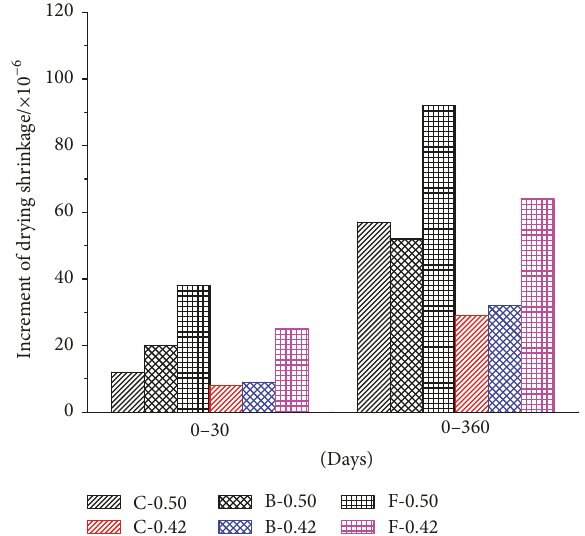
Figure 9: The increments of drying shrinkage of concretes when the wet curing time decreases from 8 days to 5 days.